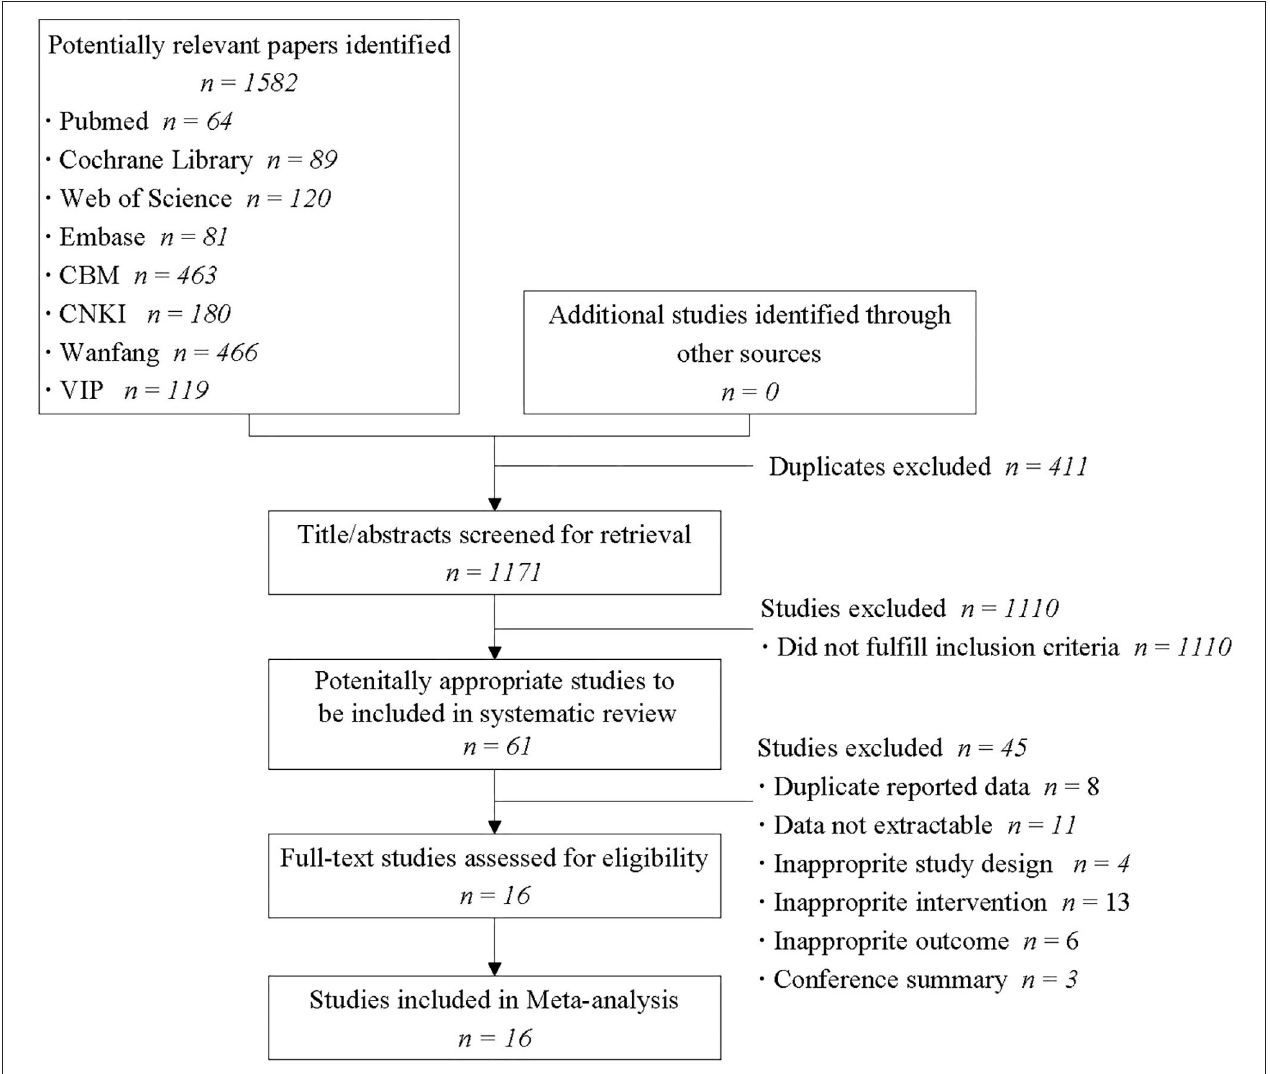
FIGURE 1 | Flow diagram of the study selection process. CBM, Chinese biomedical literature database; CNKI, China national knowledge infrastructure.